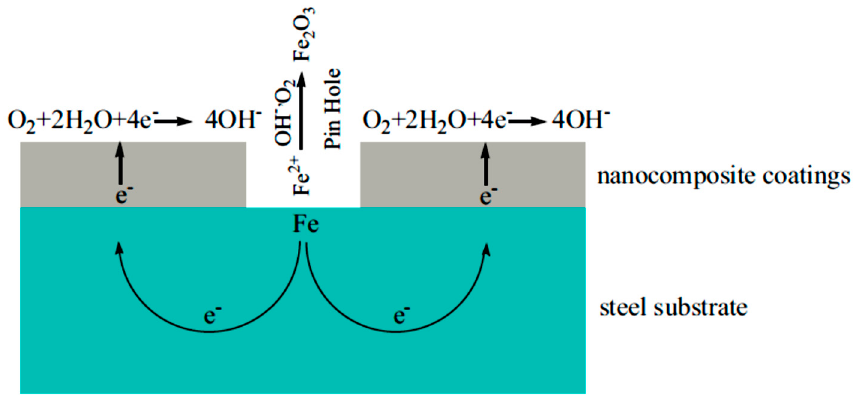
Figure 20. Schematic of anti-corrosion mechanism for the nanocomposite coating [130].